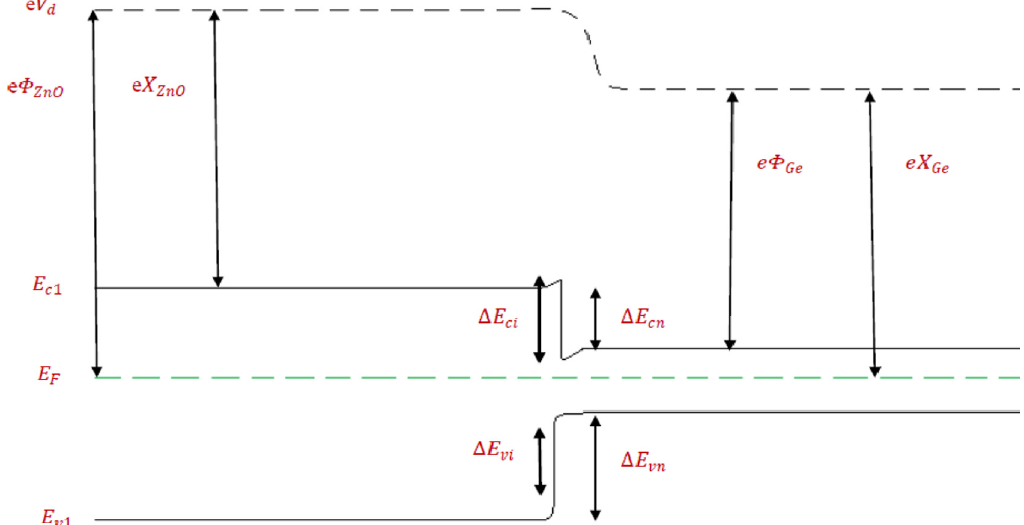
Fig. 6. Diagram of energy bands structure of ZnO/n-type